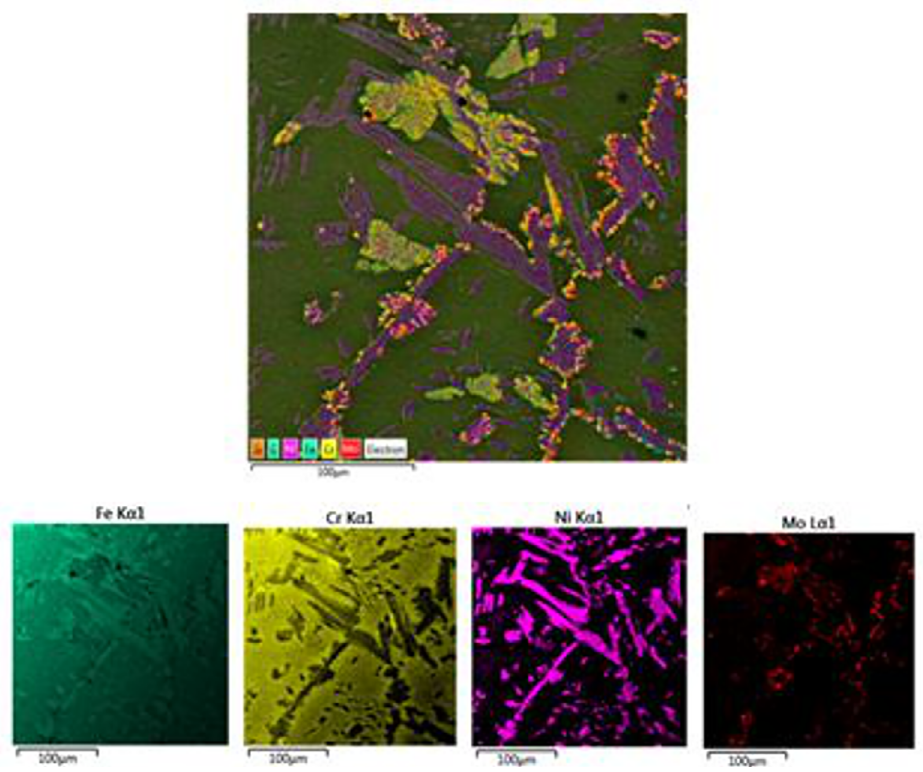
Figure 4. EDS compositional mapping for sample aged at 830C for 90 minutes.